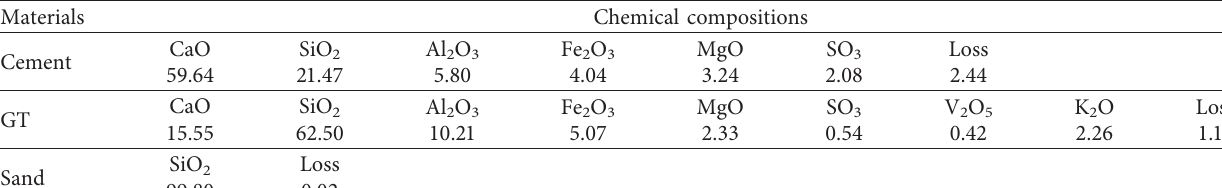
Table 2: Chemical properties of Portland cement, sand, and graphite tailings (%).